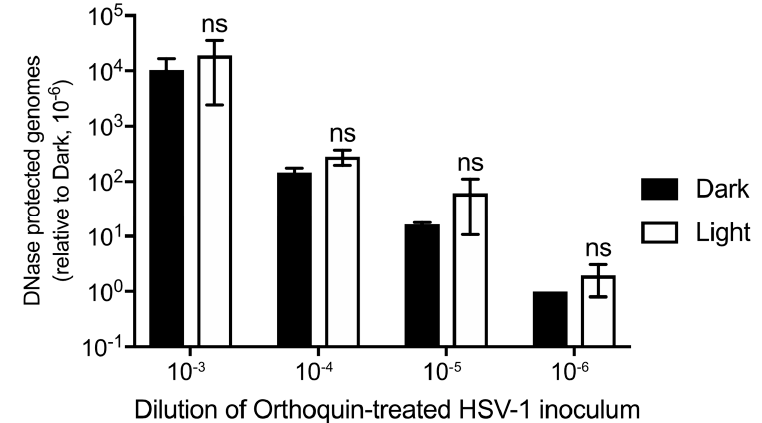
Figure 7. Orthoquin does not damage HSV-1 capsids. Four 10-fold dilutions of HSV-1 inocula were mixed with 0.1 µg/mL Orthoquin and exposed to a 65 W LED light in clear (light) or black (dark) tubes for 10 min. Following treatment, samples were treated with DNase I for 30 min at 37 °C. Viral DNA) and luciferase (recovery control). The data shown are means ± standard deviation of three independent experiments. n = 3 ± SD from three independent biological replicates; ns = non-significant by two-way